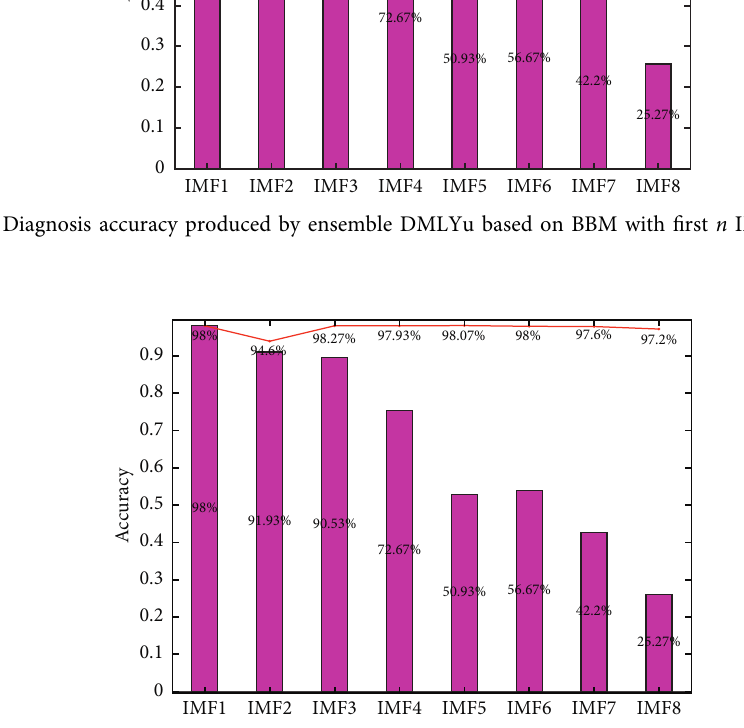
Figure 7: Diagnosis accuracy produced by ensemble DMLYu based on voting method with first n IMF components.